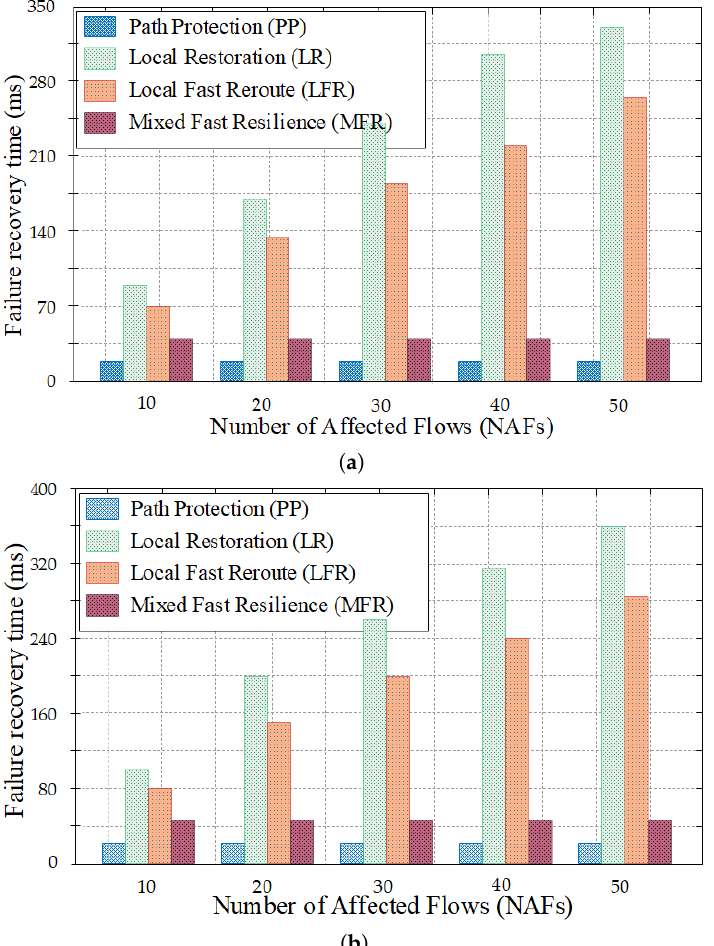
Figure 11. Failure recovery time based on the NAFs. ( a ) For the industrial network topology. ( b ) For the sprint